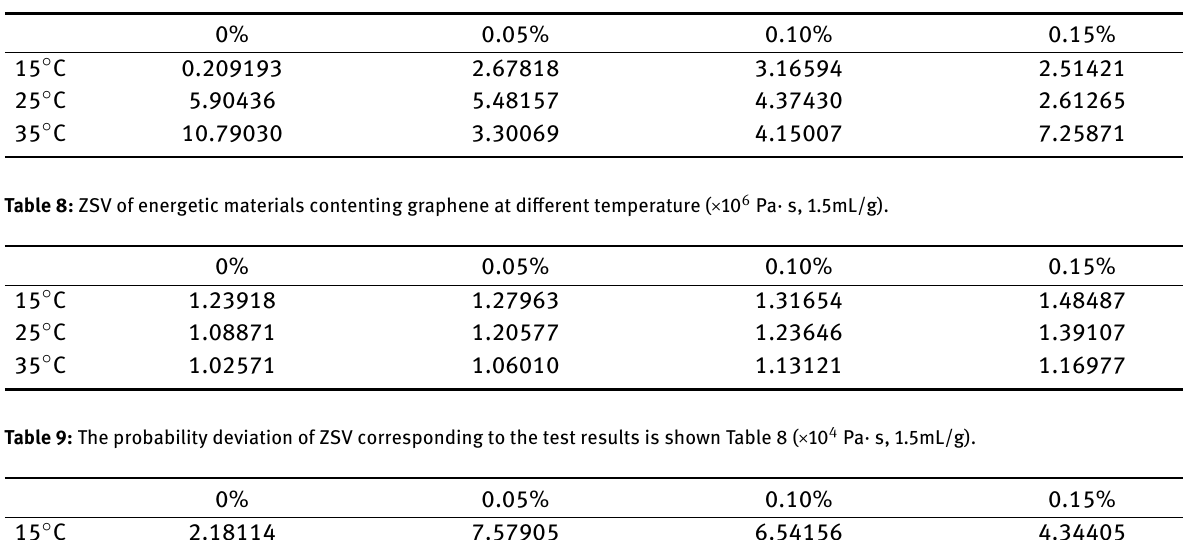
Table 7: The probability deviation of ZSV corresponding to the test results is shown Table 6 ( × 10 4 Pa · s, 1mL/g).